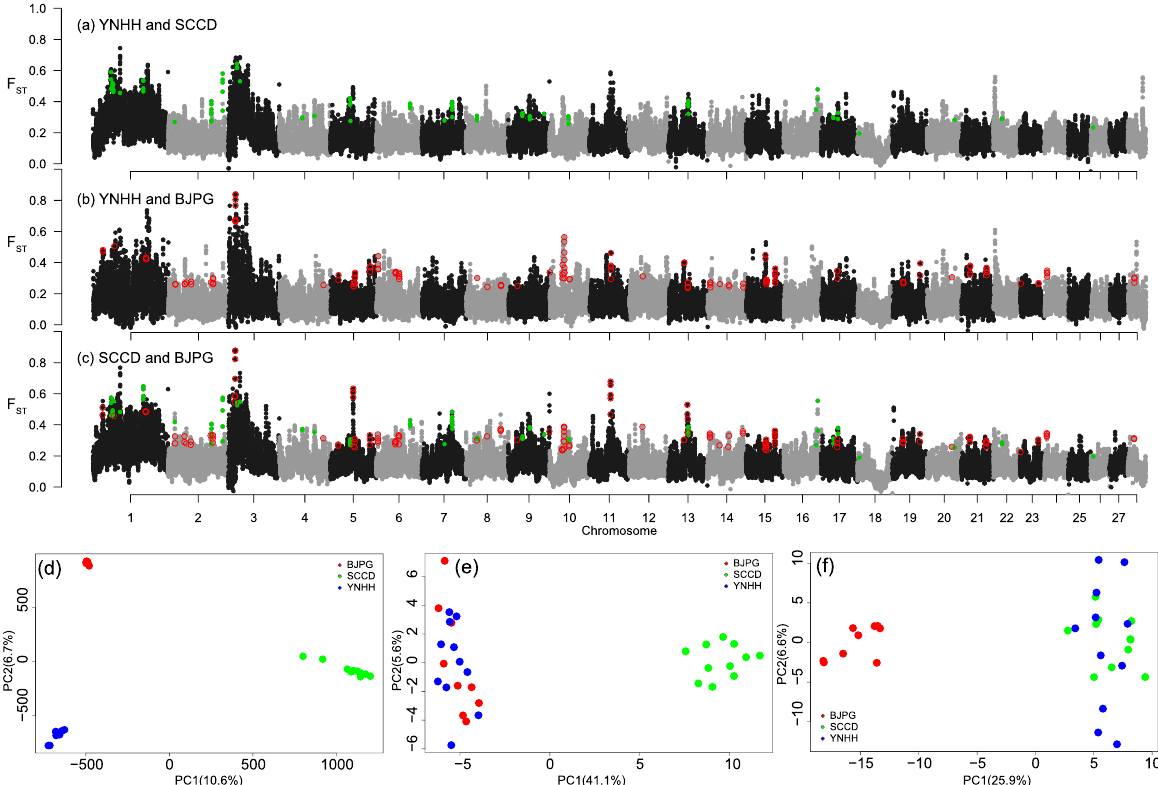
Fig. 6 Identi fi cation of SNP outliers potentially related to the endemic SCCD and postglacial colonized BJYQ population of the Grapholita molesta . a – c The plot of pairwise F ST across 28 chromosomes for YNHH/SCCD ( a ), YNHH/BJPG ( b ), and SCCD/BJPG ( c ) population pairs. Green points indicate candidate regions related to the endemicity of the SCCD population, while red circles show candidate regions related to northward dispersal of the oriental fruit moth. d – f Scatter plots from the PCA analysis of individuals based on all SNPs ( d ), SNPs potentially related to the endemicity of the SCCD population ( e ), and SNPs potentially related to the northward dispersal of BJPG population ( f